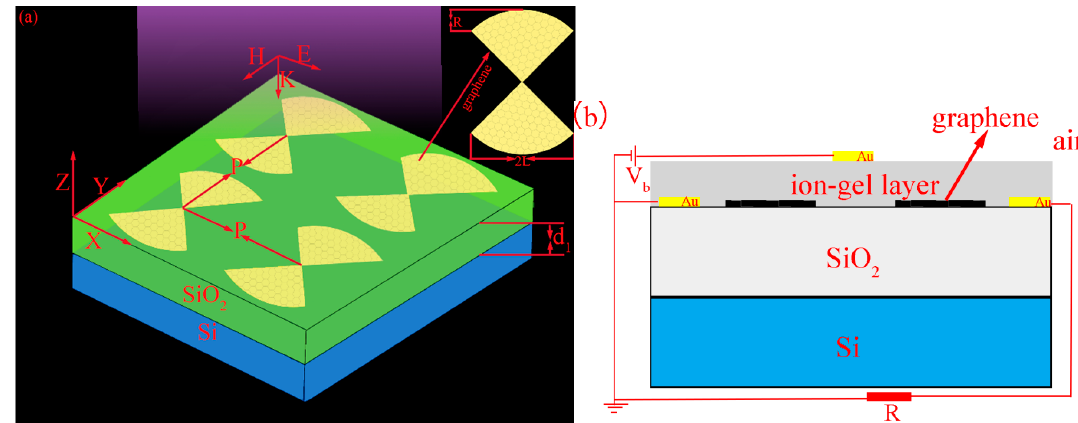
Figure 1. ( a ) The schematic of “hourglass” graphene arrays structure with period ( P ), semimajor axis ( L ), semiminor axis ( R ). The two layers of substrate structure are Si and SiO 2 . The thickness of SiO 2 is d 1 . ( b ) The side view of the structure which manipulates the chemical potential ( µ c ) of graphene by applying a voltage ( V b